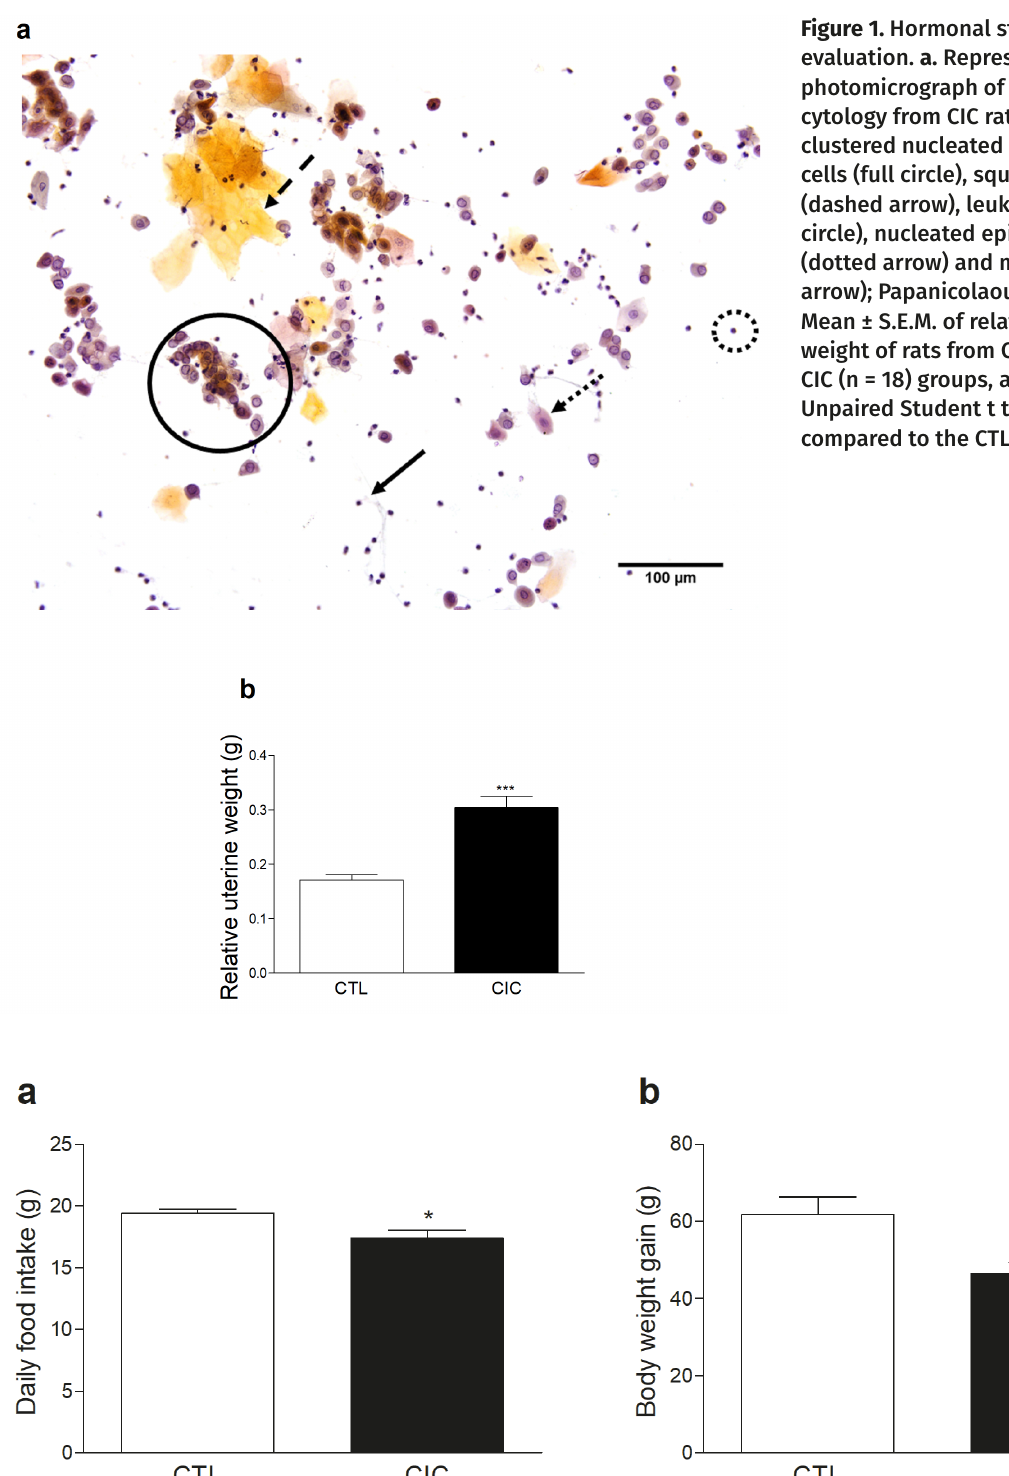
Figure 2. Food intake and total weight gain measurement. a. Daily food intake and b. Body weight gain during the treatment period of CTL (n = 12) and CIC (n = 18) groups. Data are mean ± S.E.M, analyzed by Unpaired Student t test. *P<0.05 compared to the CTL group. **P <0.01 compared to the CTL group.